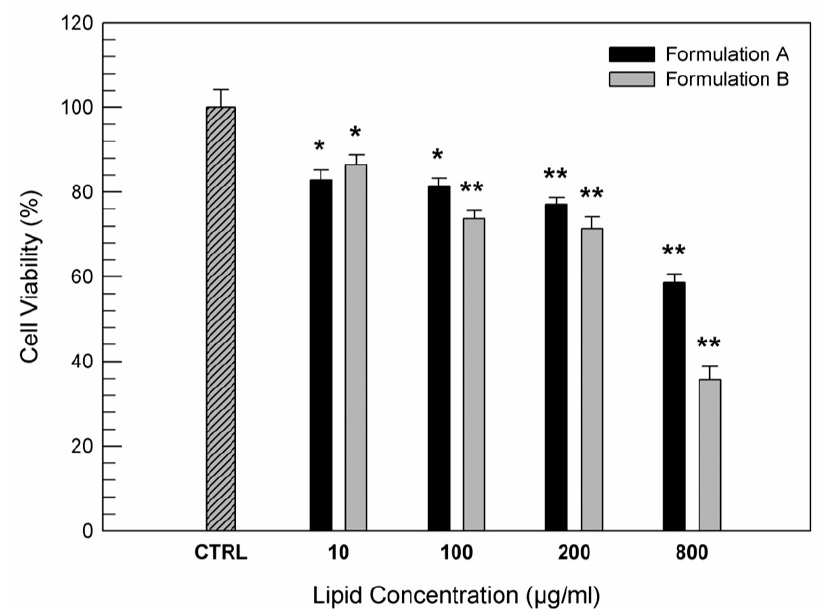
Figure 5. In vitro cytotoxic effects of Formulation A and Formulation B on CaCo-2 cells as a func- tion of lipid concentration (µg/mL). The data are expressed as a percentage of cell viability after 24h of treatments and they are the average of three different experiments ± standard deviation. * p < 0.05 and ** p < 0.001 versus control (untreated